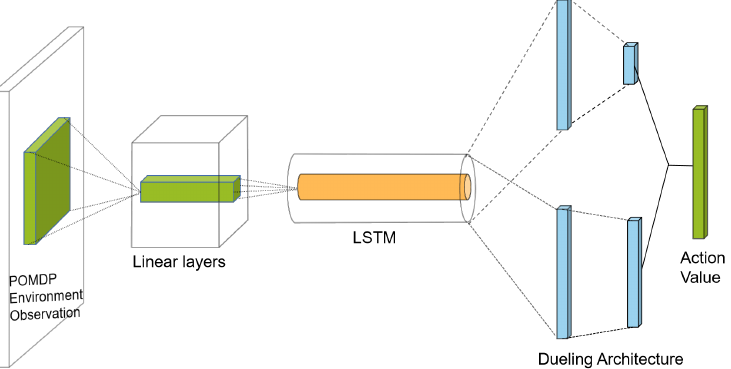
Figure 2. The network architecture of ND 3 RQN. The input of the ND 3 RQN is the POMDP environ- ment’s observation o t observed by the agent. Through the calculation of the hidden layer, the final output value of the action was used to select the action. The green parts are the same as the original DQN, that is, the fully connected layers. The orange part is the architecture of LSTM, and the blue part is the structure of dueling DQN with the noise